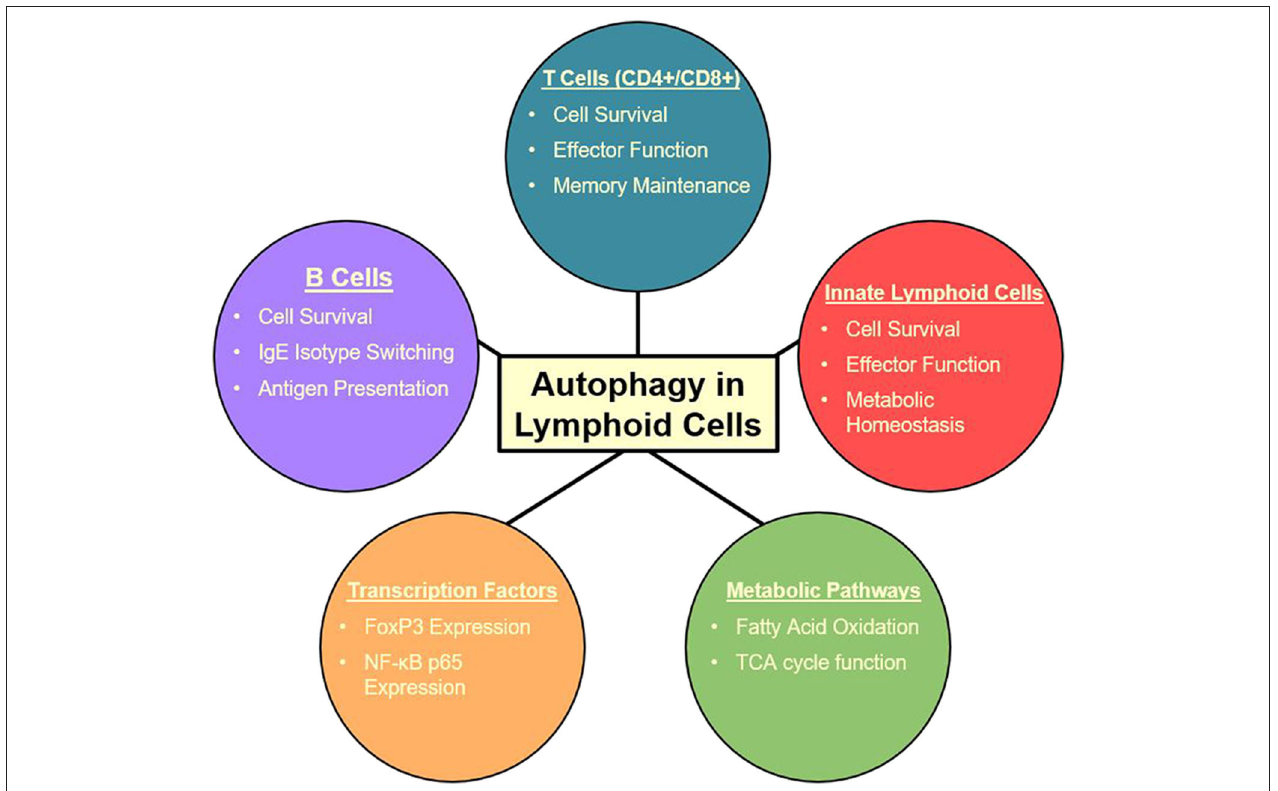
FIGURE 2 | Summary of autophagy functions in the lymphoid cell lineage (27, 105, 107–115, 117, 118,